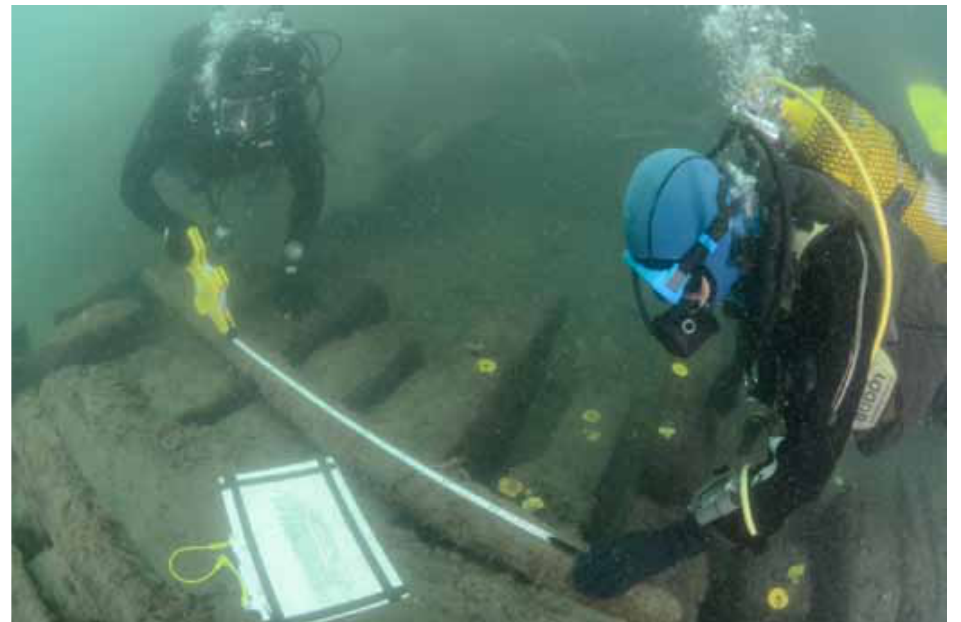
Fig. 1: Recording the Gresham Ship (photo Mark Beattie Edwards/Nautical Archaeology